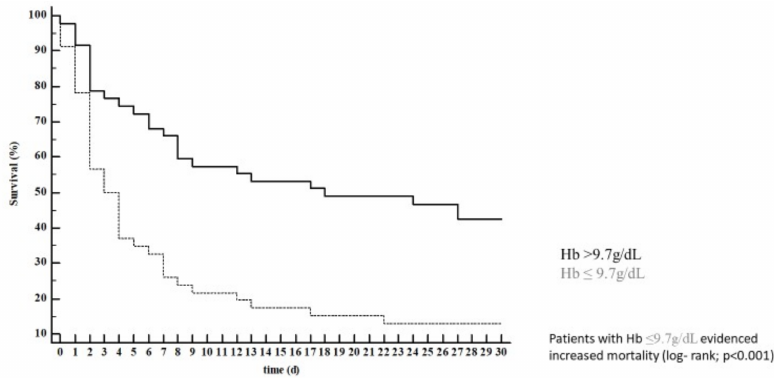
Figure 2. Patients with hemoglobin (Hb) ≤ 9.7 g/dL showed increased mortality (log- rank; p <